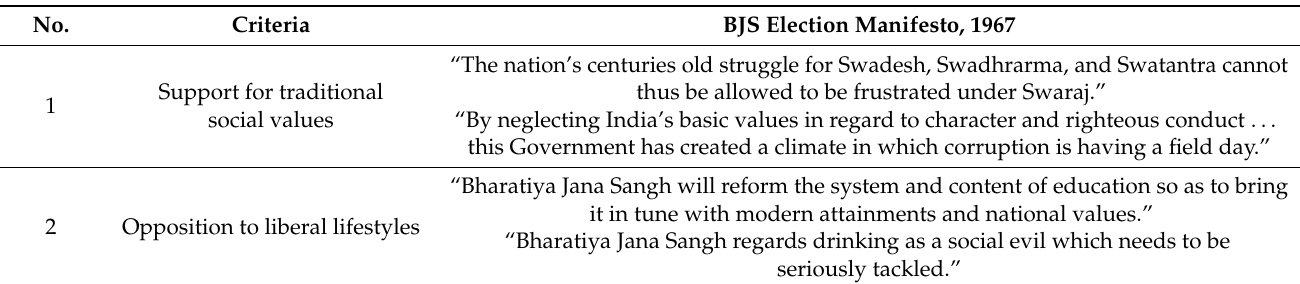
Table 2. Hindu nationalism and populism in Bharatiya Jana Sangh based on 1967 manifesto (BJS